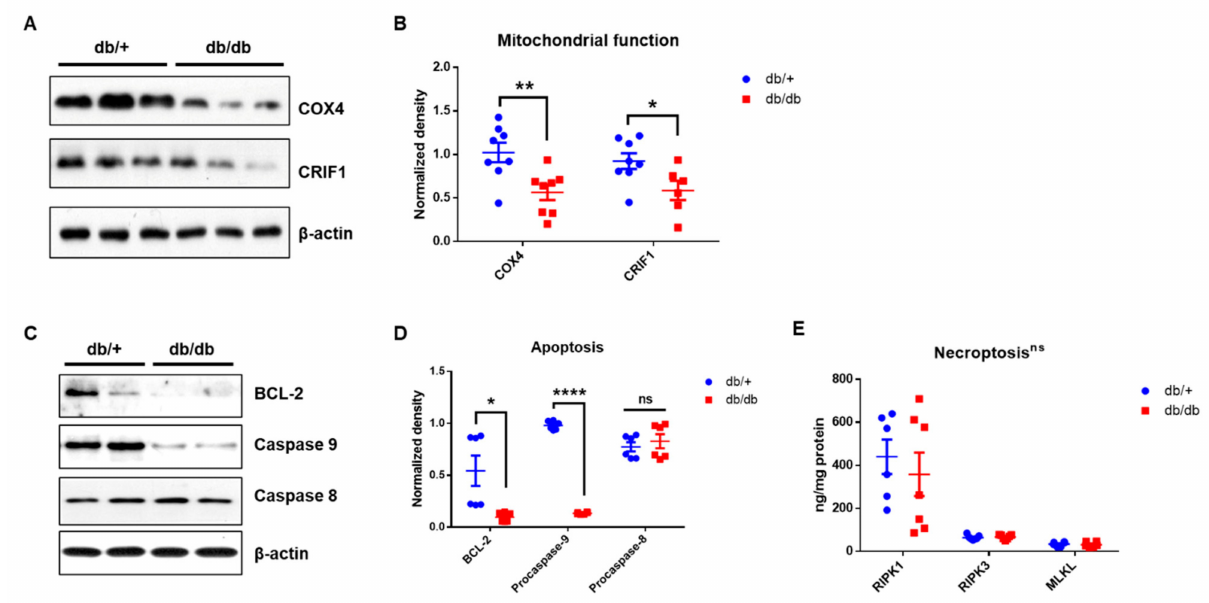
Figure 8. Dysfunctional mitochondria in the cochlea of diabetic mice. ( A , B ) Proteins required for mitochondrial oxidative phosphorylation (Cytochrome c oxidase subunit 4, COX4) and the intramitochondrial production of mtDNA–encoded OXPHOS subunits (CRIF1) were measured using Western blot. Both proteins were significantly reduced in db/db mice compared to db/+ animals. ** p < 0.01, * p < 0.05, unpaired t -test. n = 8. ( C , D ) Diabetic cochlea displayed an activation of BCL-2 and caspase-9, but not caspase 8. **** p < 0.0001, * p < 0.05, unpaired t -test. n = 6. ( E ) Necroptosis markers, RIPK1, RIPK3, and MLKL, showed no significant changes between db/db ( n = 7) and db/+ ( n = 6) mice. ns, not